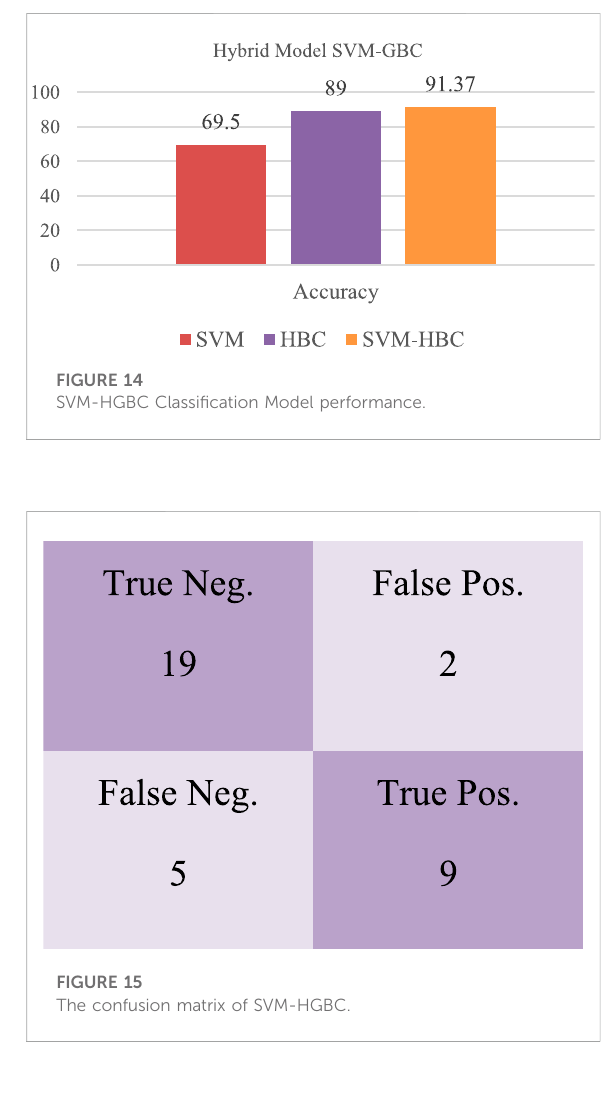
FIGURE 13 Hybrid classi fi er (SVM-XGB classi fi cation) model.